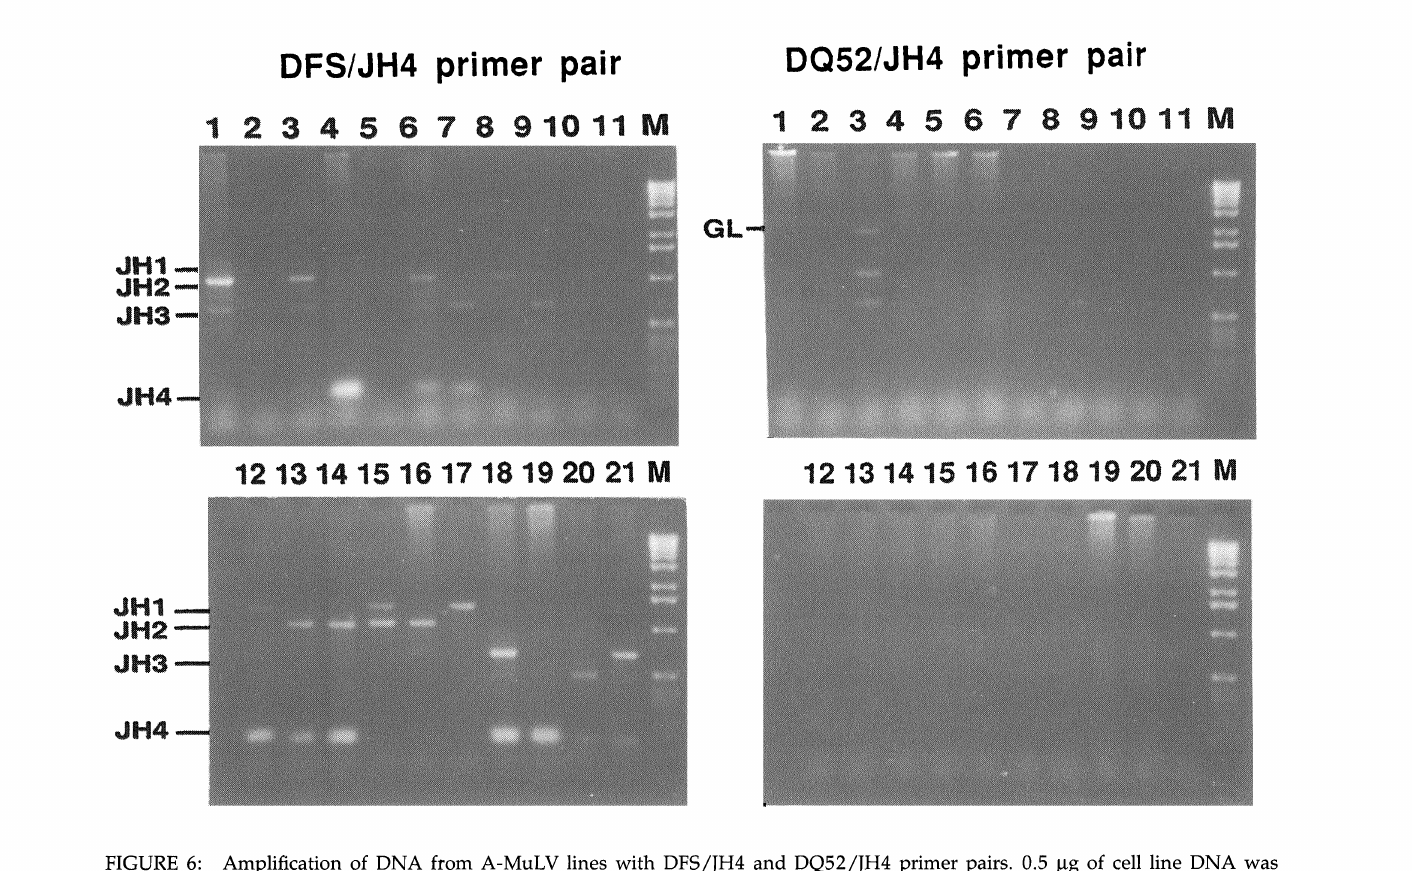
FIGURE 6: Amplification of DNA from A-MuLV lines with DFS/JH4 and DQ52/JH4 primer pairs. 0.5 tg of cell line DNA was amplified as described in the text and the products visualized on an ethidium bromide-stained agarose gel. Markers at the side denote the positions of DJH1 (1.3 kb), DJH2 (1 kb), DJH3 (0.7 kb), and DJH4 (0.13 kb) rearrangements as well as the germline (GL)-sized bands (2 kb). The PCR assay is described in detail in Chang et al. (1992) and in Materials and Methods. Lanes 1-21 are amplifications of 21 A-MuLV lines. Lane M is the 1-kb ladder